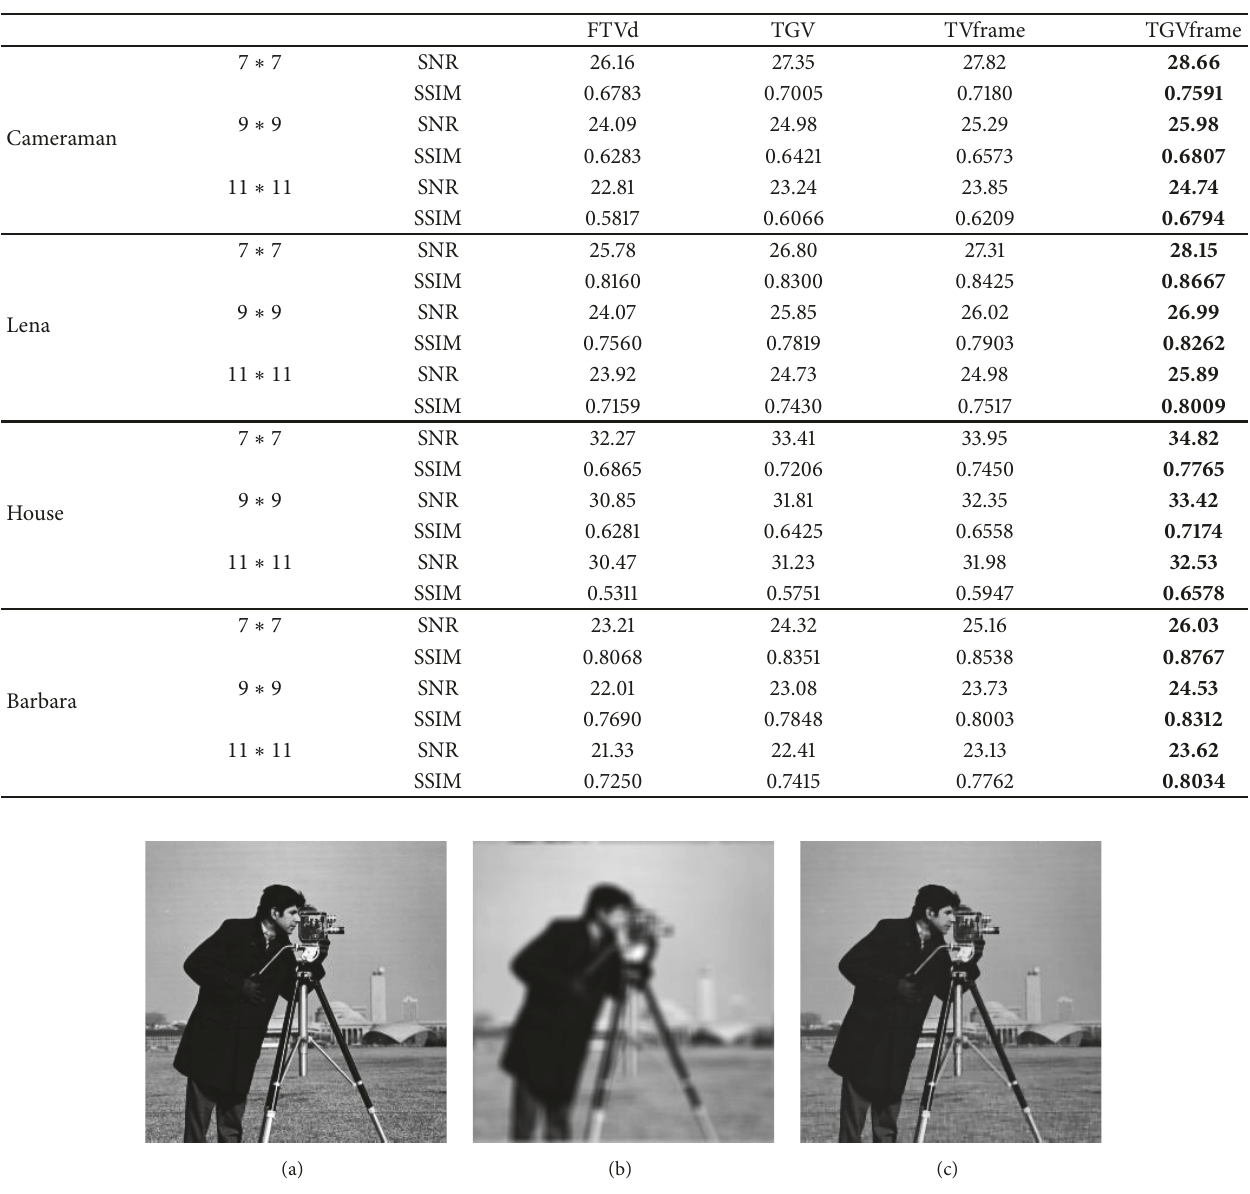
Table 1: Restoration results of different methods under gaussian blur with noise level 𝜎 = 0.1 .